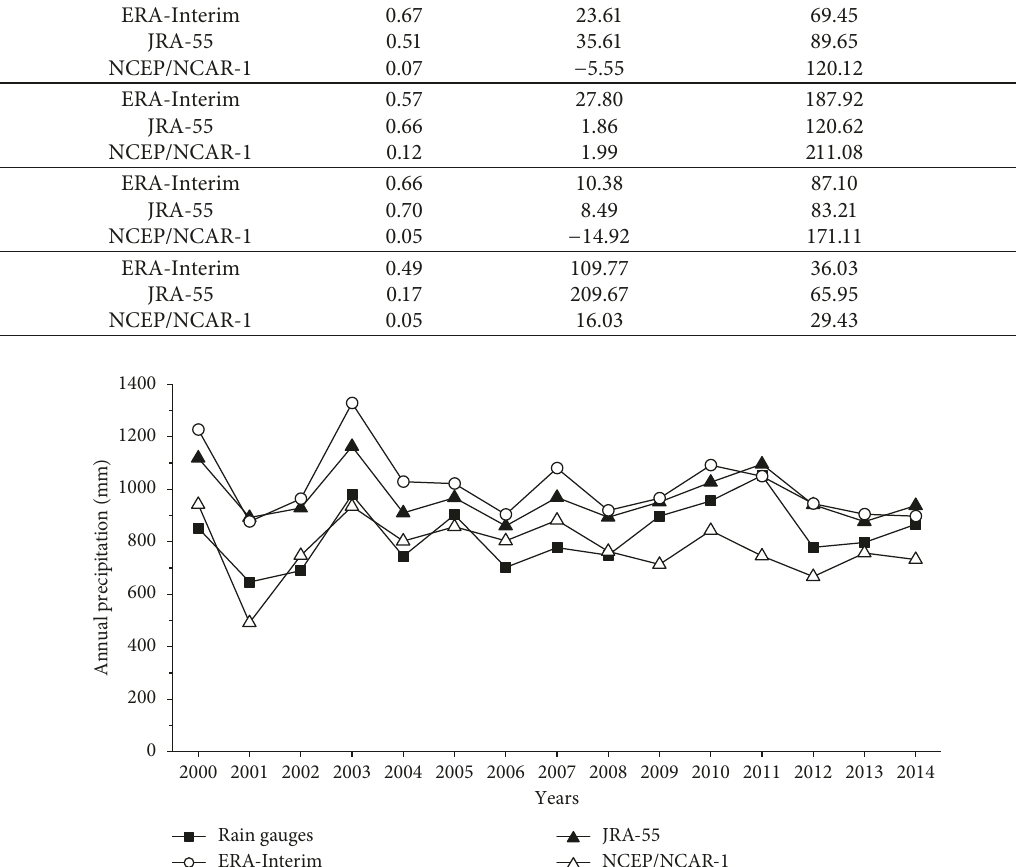
Table 3: CC, BIAS, RMSE, and MAE between three reanalysis precipitation datasets and gauged precipitation data at the seasonal scale over the Qinling-Daba Mountains, China (all products passed the significance test at the 99% confidence level). Season